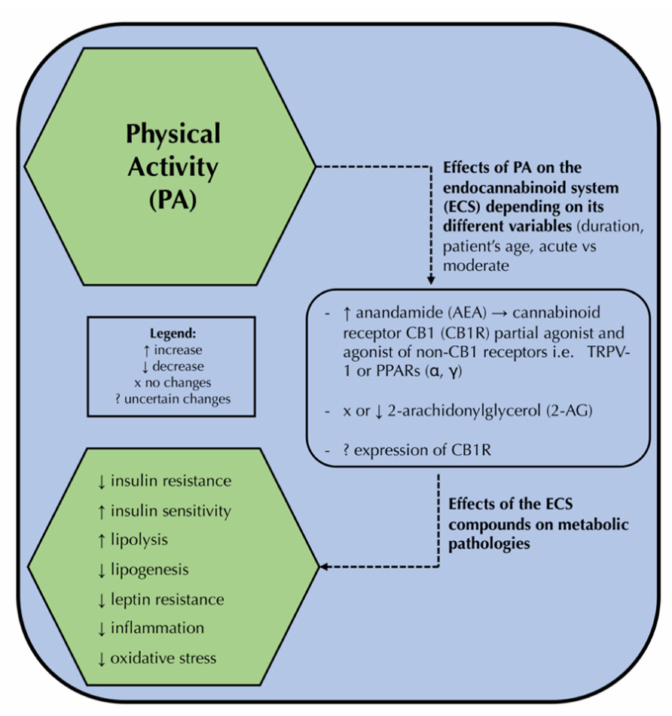
Figure 2. The effect of physical activity on the endocannabinoid system components and, subse- quently, its possible impact on the attenuation of metabolic pathologies. PA: physical activity, ECS: endocannabinoid system, AEA: anandamide, CB1R: cannabinoid receptor type 1, ECS: the endo- cannabinoid system, TRPV-1: transient receptor potential vanilloid 1 ion channel, PPAR: peroxisome proliferator-activated receptors α , 2-AG: